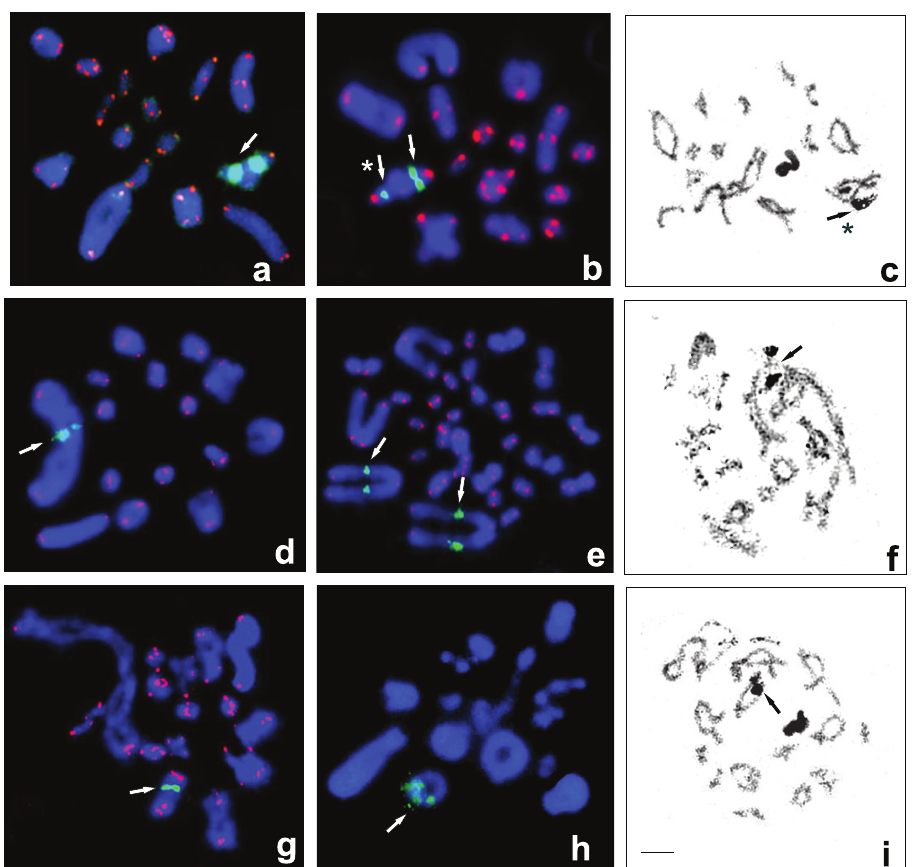
Figure 2. FISH using 18S rDNA (green) and telomeric TTAGG (red) probes on male ( a, b, d, g, h ) and female ( e ) karyotypes and silver staining ( c, f, i ). Diplotene of Pholidoptera ( a–g ) and Uvarovistia ( h, i ) species. White arrows point to rDNA clusters on the medium acrocentric pair or on the bi-armed first pair of autosomes. Black arrows indicate the active NOR co-localized with rDNA. a P. fallax and b, c P. pustulipes (2n = 31). Asterisks point to differences in size/strength of rDNA/NOR between ho- mologous chromosomes d–f P. macedonica (2n = 29). Arrows indicate high-intensity rDNA signal and NOR located in the paracentromeric region of the bi-armed first pair of autosomes g P. brevipes (2n = 29). Arrows point 18S rDNA cluster on medium-sized bivalent h, i U. satunini (2n = 31) . Bar = 10